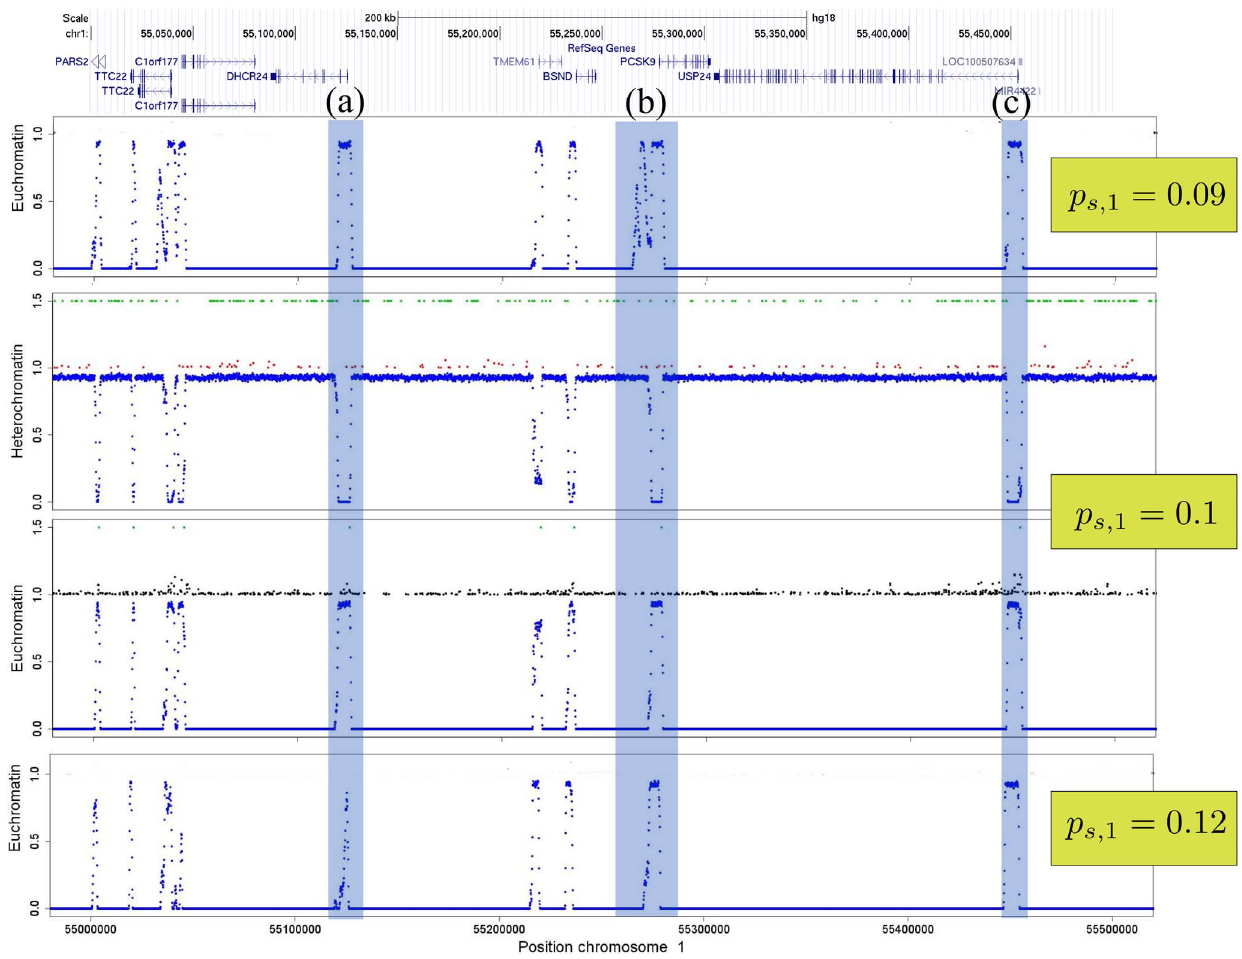
Figure 6. Example for rearrangements of heterochromatin and euchromatin due to changes of the propagation rate on chromosome 1. We zoomed on a region of 0.5 Mbp. Red dots correspond to ChIP-seq scores of euchromatin marks and black dots to the ones of heterochromatin marks. Green dots are respective nucleation sites and blue denotes simulations. On this scale, ChIP-seq data becomes sparse even when taken from multiple marks. However, the heterochromatin marks mostly disappear at the euchromatin domains where the euchromatin marks reach higher scores. Although this zoom was taken on an arbitrary region of the first chromosome, we see 3 different reactions of the system to alterations of the propagation rate, p s ,1 : (a) the euchromatin domain disappears for higher propagation rates; (b) a large euchromatin domain develops at low propagation rates; (c) the euchromatin domain remains unchanged. (a) and (b) exhibit characteristic regions for potential gene regulations. Refseq gene locations where adopted from http://genome.ucsc.edu ([74]). Other parameter values were p s ,2 ~ 0 : 1 , p d ~ 0 : 01 , p a ~ 0 : 03